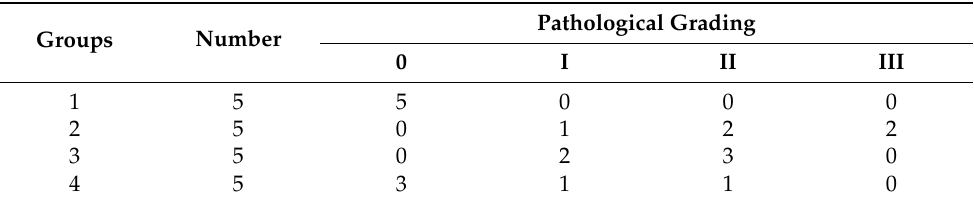
Table 6. Effect of chemical and natural iron oxide nanoparticles on the pathological grading of lead toxicity in splenic tissue of different treated